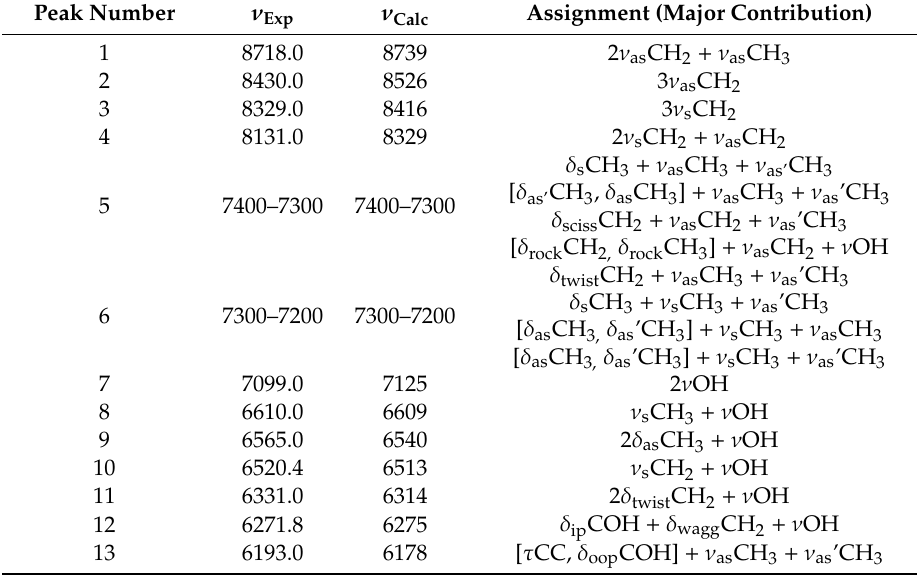
Figure 6. Band assignments in NIR spectra of deuterated ethanols based on GVPT2 // B2PLYP-GD3BJ / def2-TZVP // CPCM calculations. ( A ) CD 3 CD 2 OH; ( B ) CD 3 CD 2 OD; ( C ) CH 3 CD 2 OD; ( D ) CD 3 CH 2 OD. Band numbering corresponds to that presented in Tables 6–9. Table 2. Band assignments in NIR spectra of CH 3 CH 2 OH based on GVPT2 // B2PLYP-GD3BJ / def2-TZVP // CPCM calculations. Band numbering corresponds to that presented in Figure 5A.